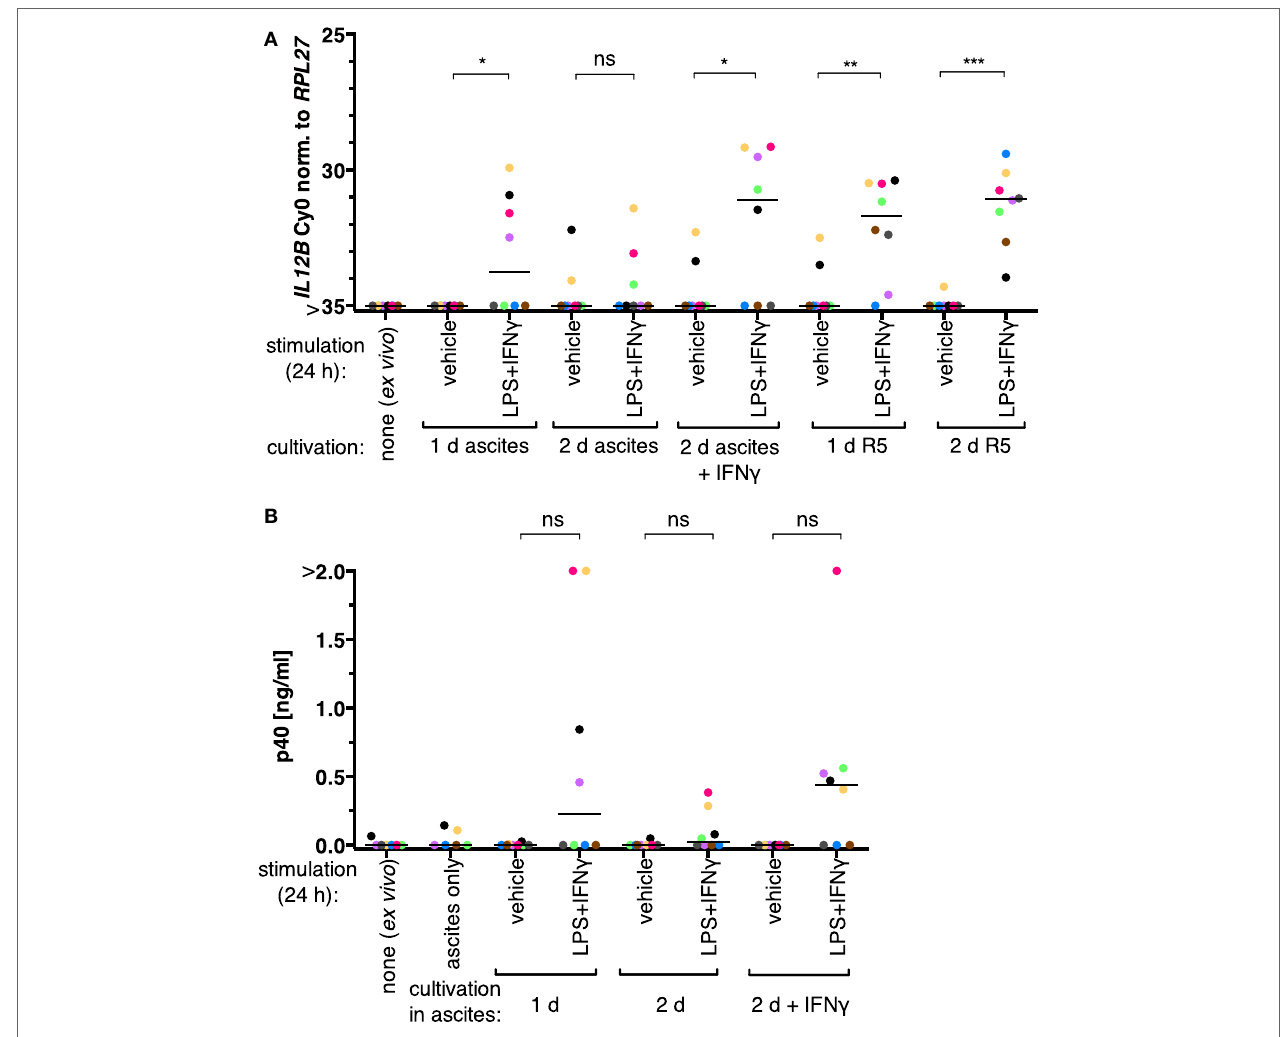
FigUre 1 | IL-12 production by tumor-associated macrophages from ovarian carcinoma patients is suppressed by ascites in vitro . (a) Ex vivo TAMs ( N = 8) were cultivated in autologous ascites in the presence or in the absence of IFN γ or in normal medium (R5) as indicated, and non-cultivated ex vivo TAMs served as an additional control. LPS and IFN γ or their respective solvents (vehicle) were added to the culture supernatants for 24 h prior to harvesting, and IL12B expression was measured by RT-qPCR. (B) Secreted IL-12p40 from these TAMs was measured by ELISA ( N ≥ 6). Cell-free autologous ascites was used as additional control. Each dot denotes a biological replicate. Median values are indicated by horizontal bars. Colors encode individual patients, and colors are consistent between panels within this figure. Statistical significances were calculated with paired t -tests. * P < 0.05; ** P < 0.01; *** P < 0.001; ns, not